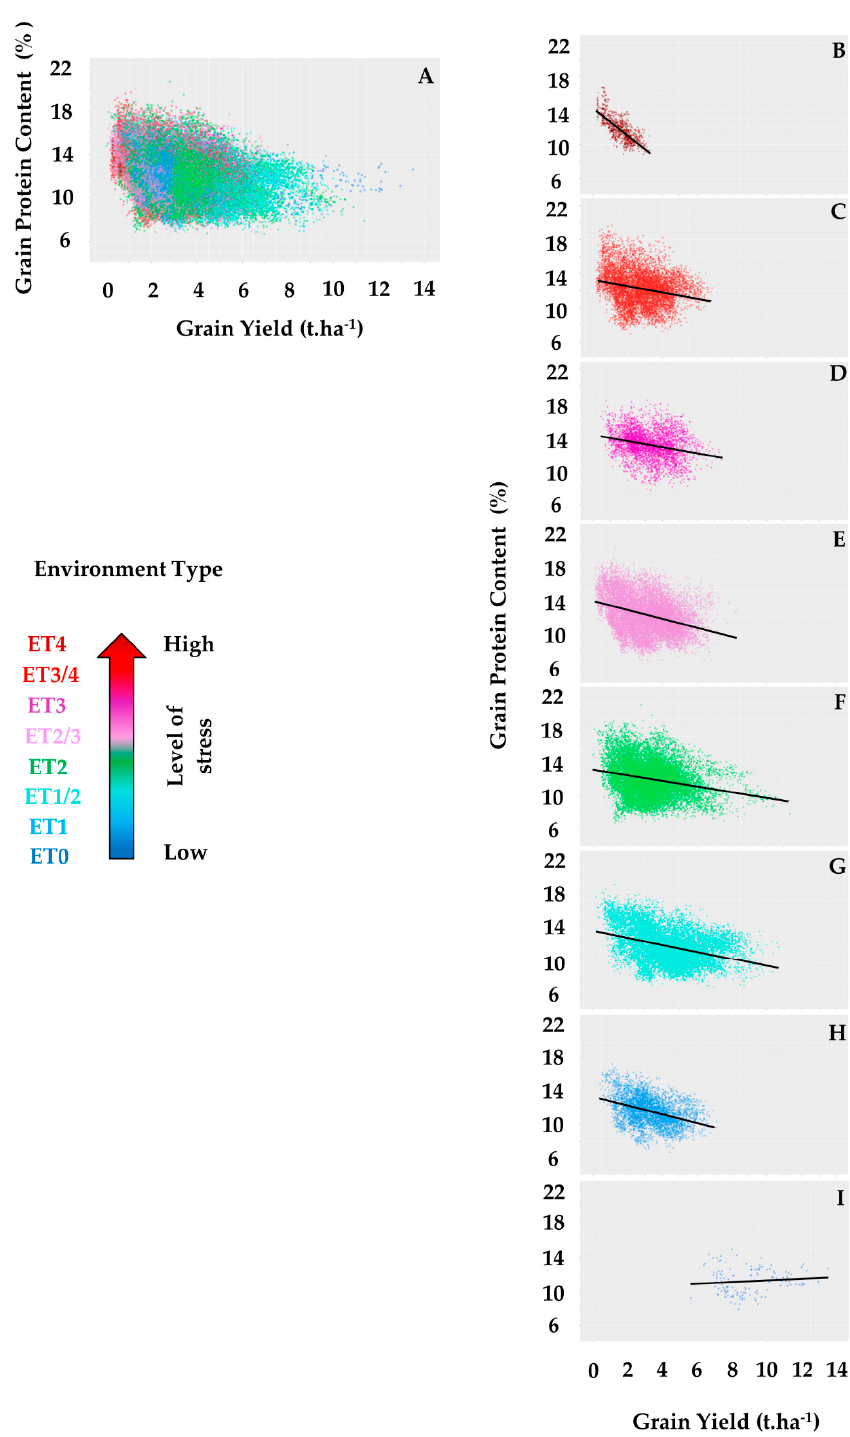
Figure 2. Relationship between grain yield and grain protein content across all ( A ) and in the individual environment types (ETs) ( B–I ). For the entire dataset ( A ), 215 wheat varieties were grown in 206 NVT sites across the Australian wheat-belt and Tasmania. The total number of varieties × site × year × season data in ( A) were 52,822. The number of varieties, years and sites for the individual ETs in ( B–I) are shown in Table 1. The lines in ( B–I) show the best linear fit to the data. The negative relationships in all figures, except (I), are significant. The highest and lowest R 2 values are 0.57 and 0.01 for (B) and (I),